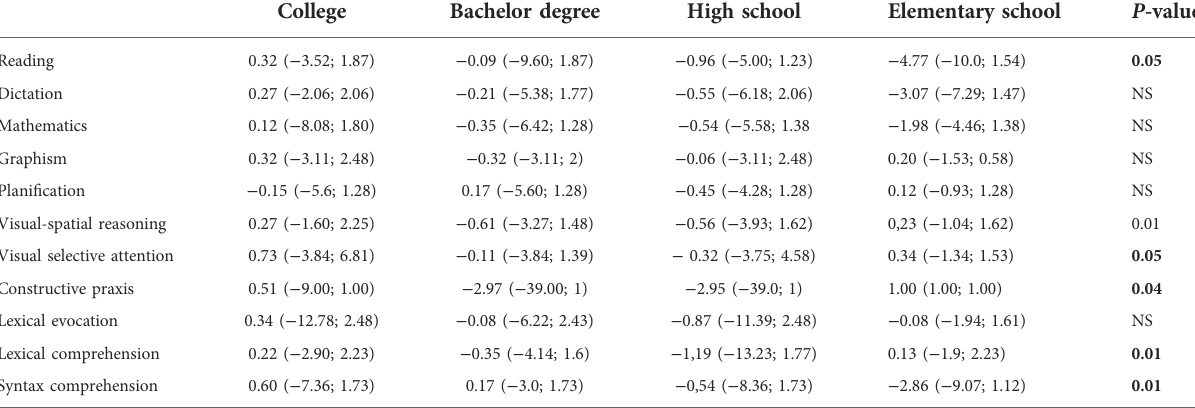
TABLE 3 Mean (min-max) Z-scores of the EDA according to the mother ’ s education level.